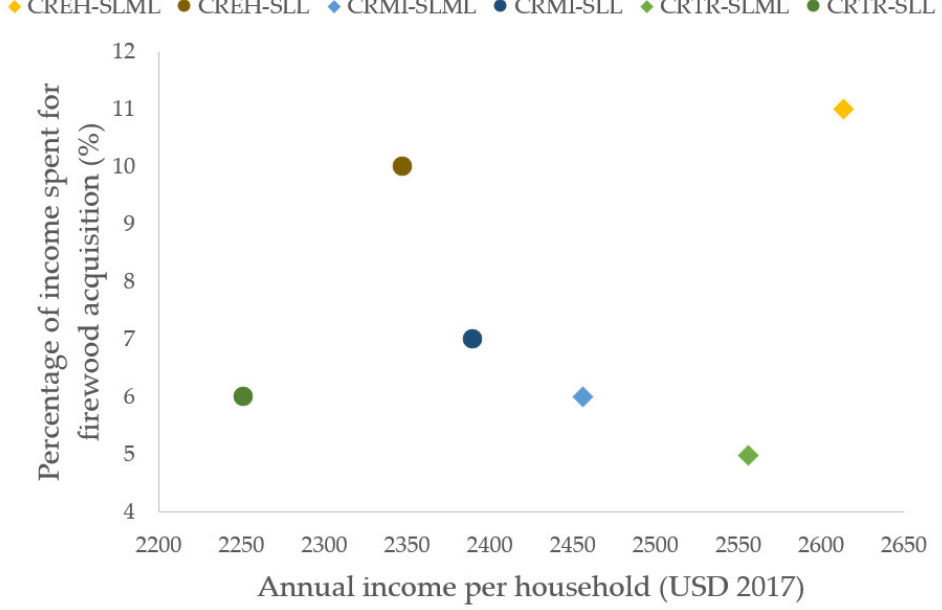
Figure 8. Percentage of household income spent by mixed users of firewood MPU on acquiring firewood by climate region and socioeconomic level. EH, extreme heat; MI, mild; TR, tropical; ML, moderately low; L, low. Source: Own elaboration.